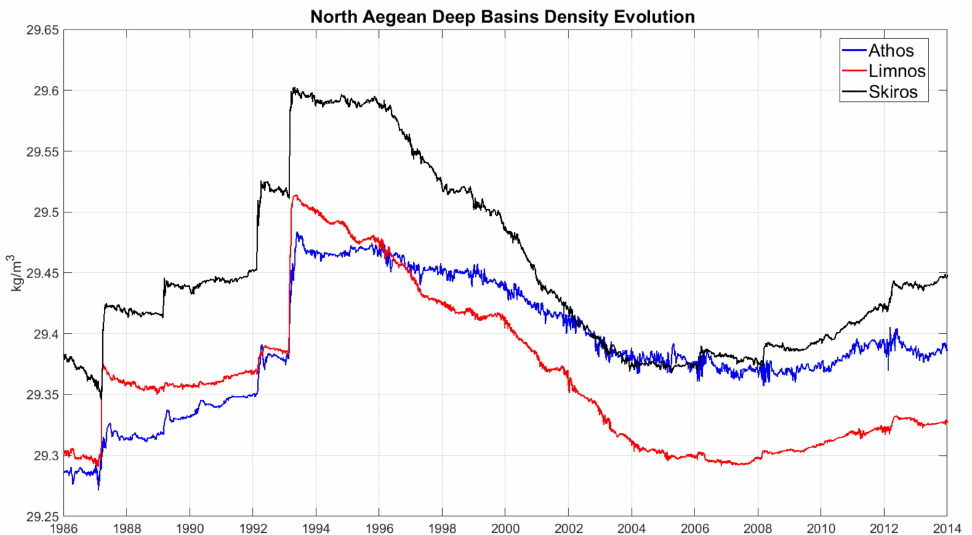
Figure 14. North Aegean deep basins potential density ( σ θ 0 ) evolution vertically integrated from 600 m to maximum depth for the period from 1986 to 2013. The red line refers to Lemnos basin, the blue line to Athos basin and the black line to Skyros